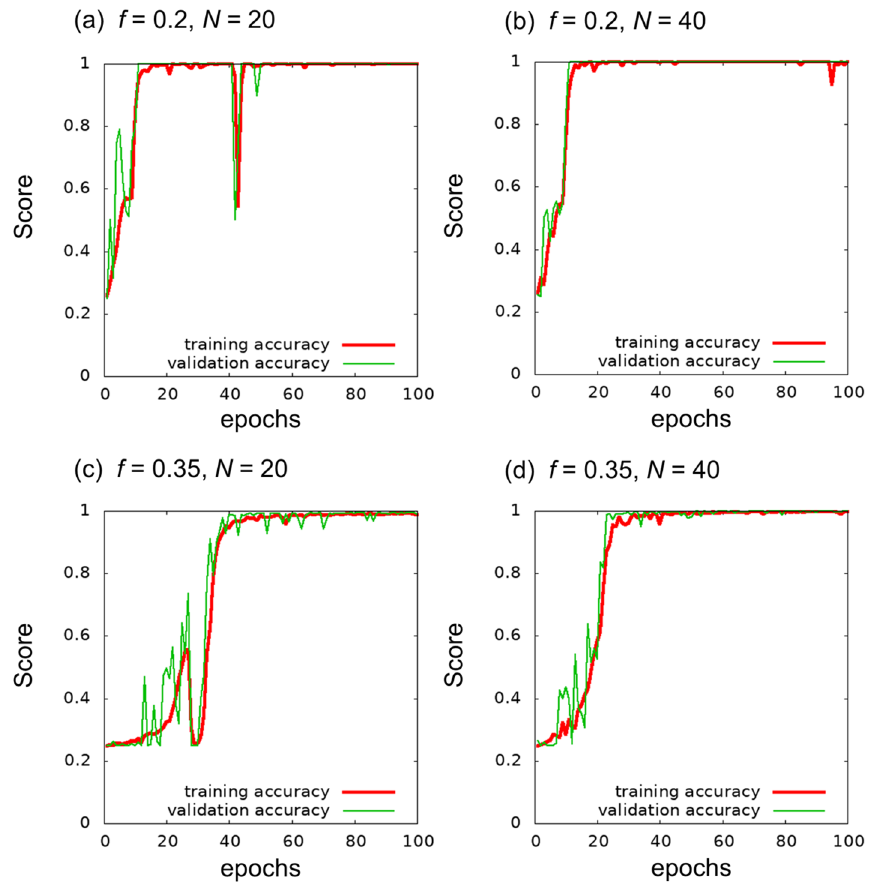
Figure 2. Learning curves of the 4-class image classification under training until 100